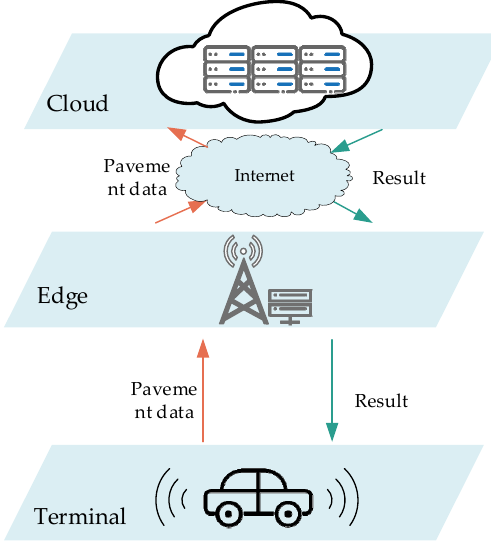
Figure 1. System